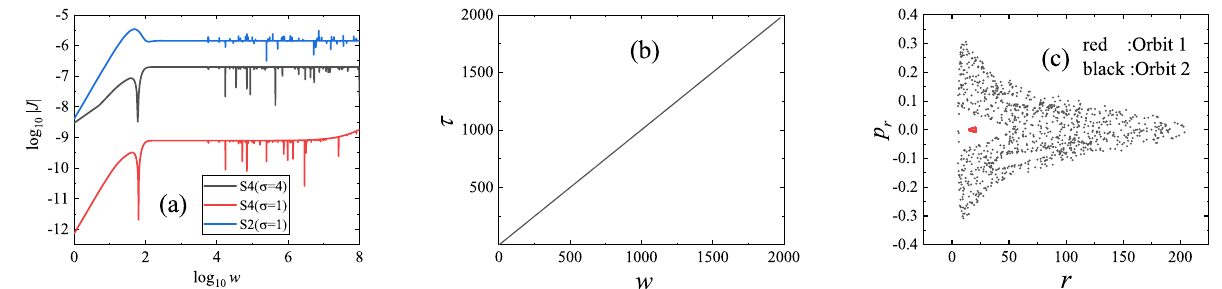
Figure 1. ( a ) Errors of the Hamiltonian J in Equation (12). S2 ( σ = 1) represents the second-order method S2 with time step σ = 1; S4 ( σ = 1) means the fourth-order method S4 with new coordinate time step σ = 1, and S4 ( σ = 4) stands for the fourth-order method S4 with time step σ = 4. Orbit 1 with the initial separation r = 15 is tested. Orbit 1 has the other initial conditions p r = 0, θ = π /2 and p θ > 0 determined by J = 0. The parameters are E = 0.9965, L = 4, Q = 6 × 10 − 4 , k 0 = 10 − 3 , k 1 = 10 − 2 , k 2 = 10 − 1 and k 3 = 1. The error for S4 ( σ = 1) is three orders of magnitude smaller than for S2 ( σ = 1). The error remains bounded for S2 ( σ = 1), but it has a secular drift for S4 ( σ = 1) due to roundoff errors. The secular drift in the error loses for S4 ( σ = 4). ( b ) Relation between proper time τ and new coordinate time w . This shows that τ and w are almost the same. ( c ) Poincaré sections at the plane θ = π /2 with p θ > 0. Orbit 1 is ordered, whereas Orbit 2 with the initial separation r = 50 is chaotic. Panels ( b , c ) come from the results provided by the algorithm S4 ( σ =